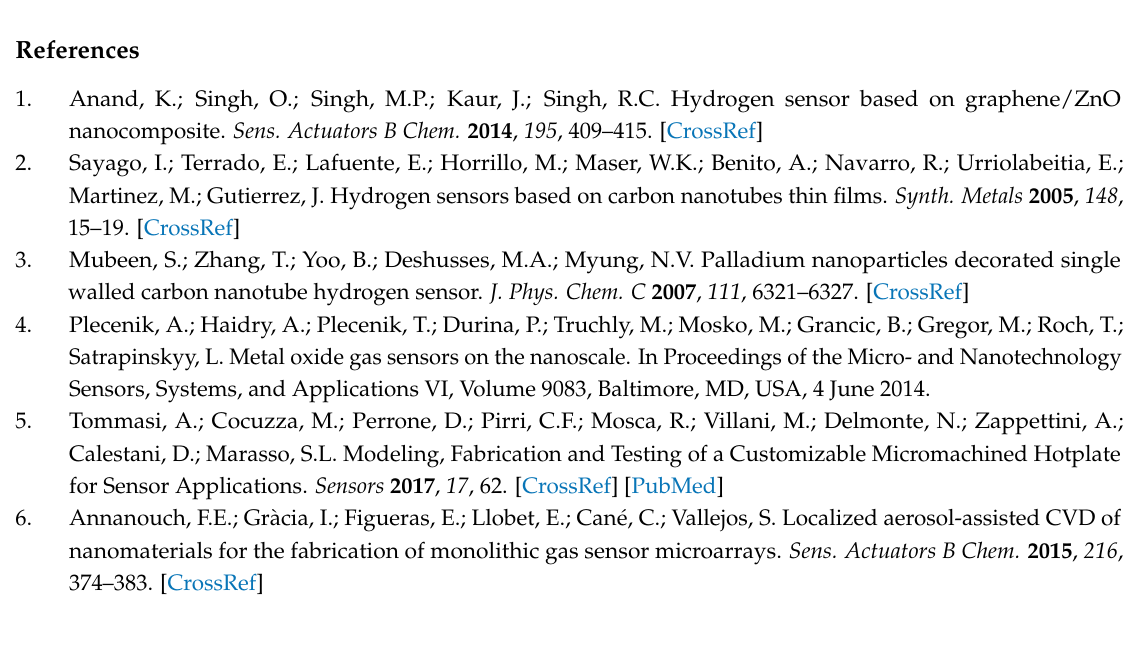
Figure S1: (a) Optical microscope (OM) and (b) TEM images of the as-received graphene, Figure S2: Schematic of sensing system, Figure S3: (a) Surface and (b) cross-sectional morphology of porosity generated on the pristine Si substrate with an average thickness of 90 µ